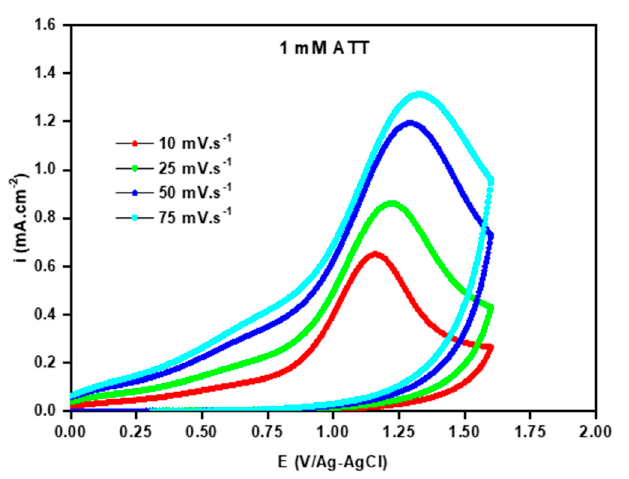
Figure 7. Oxidation-related voltammograms of ATT at different scan rates on 60Cu-Zn40 brass. Table 2. Characteristics of voltamperograms obtained at the different scanning speeds.